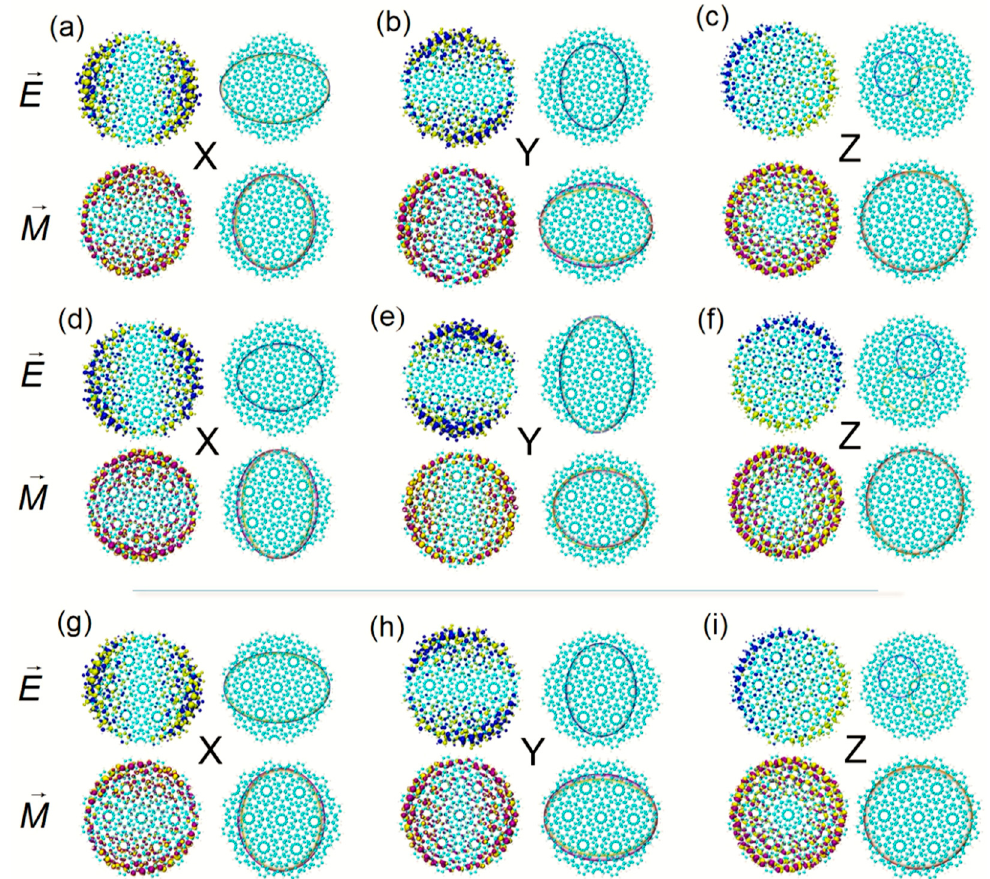
Figure 2. The theoretical calculation of TEDM (yellow isosurface represents a negative value, blue isosurface represents positive value) and TMDM (yellow isosurface represents a negative value, purple isosurface represents positive value) of Z-TwBLG-QDs-27.8° at S 13 and its TEDM S and TMDM S of Cartesian component ( a – c ), respectively. TEDM and TMDM of Z-TwBLG-QDs-27.8° at S 14 and its TEDM S and TMDM S of Cartesian component ( d – f ), respectively. TEDM and TMDM of Z- TwBLG-QDs-32.2° at S 13 and its TEDM S and TMDM S of Cartesian component ( g – i ), respectively.